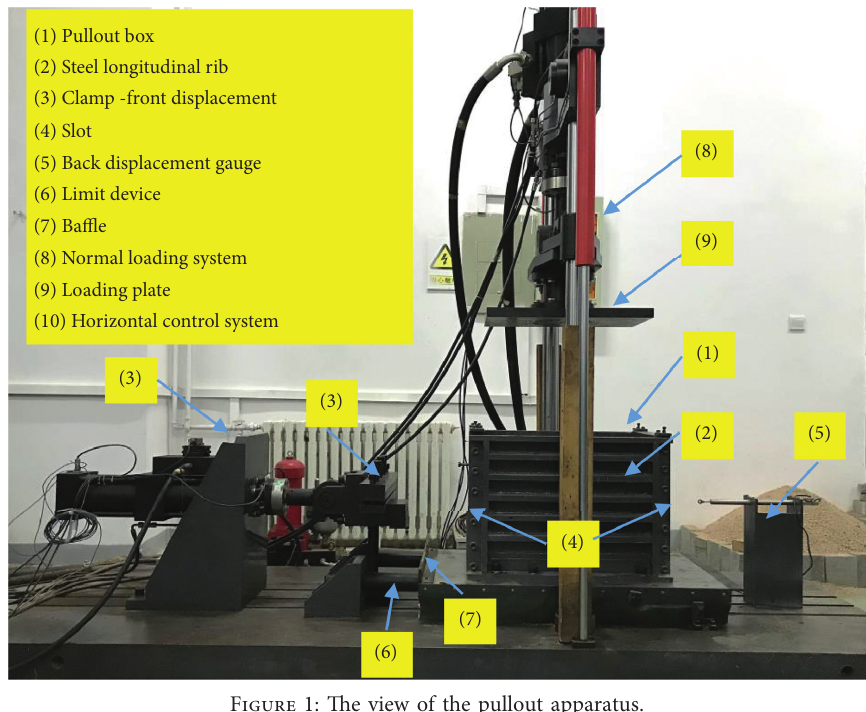
Figure 1: The view of the pullout apparatus.